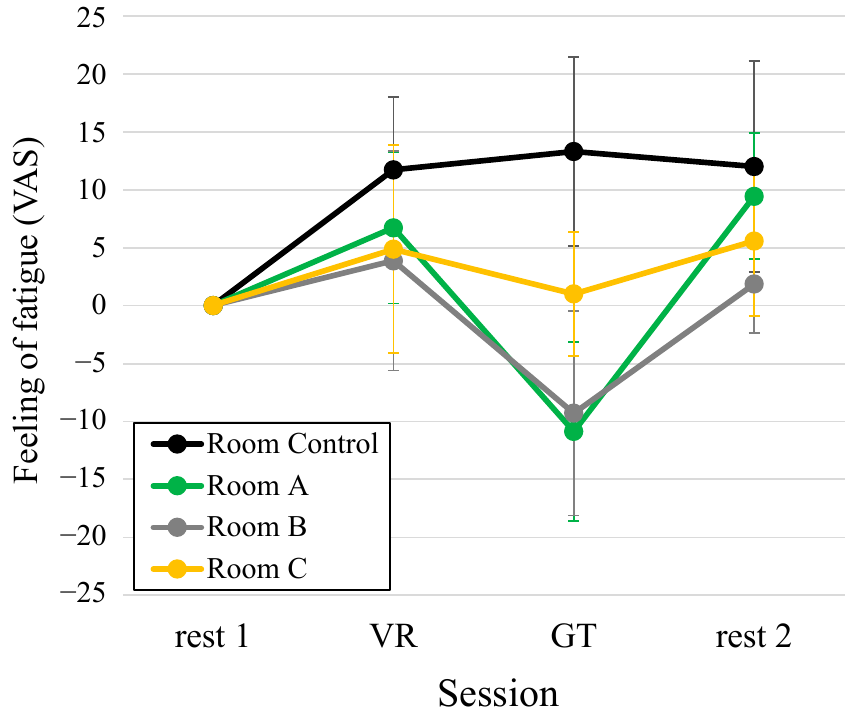
Figure 5. Change in the visual analog scale value of the feeling of fatigue in the prefrontal cortex during the experiment (rest 1, VR, GT, rest 2). Data are expressed as mean ± standard errors ( n = 7). VR, visual reality; GT, test space; Room Control, space without natural green features; Room A/B/C, space with natural green features.